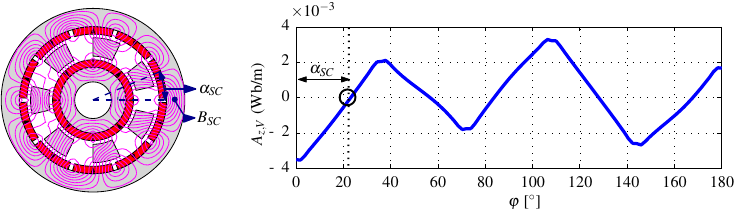
Figure 16. The circled zero crossing of A z , V indicates the angle α SC , over which flux passes through the stator